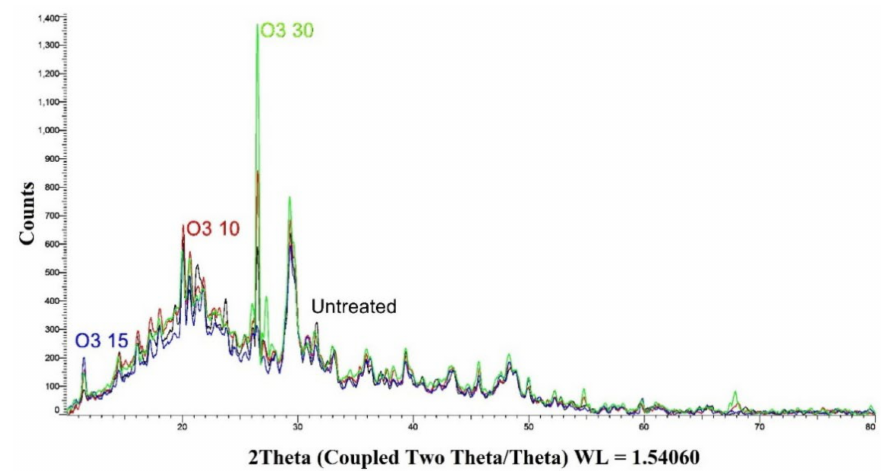
Figure 4. X-ray diffractograms of Ulva lactuca pretreated in raw and ozonated